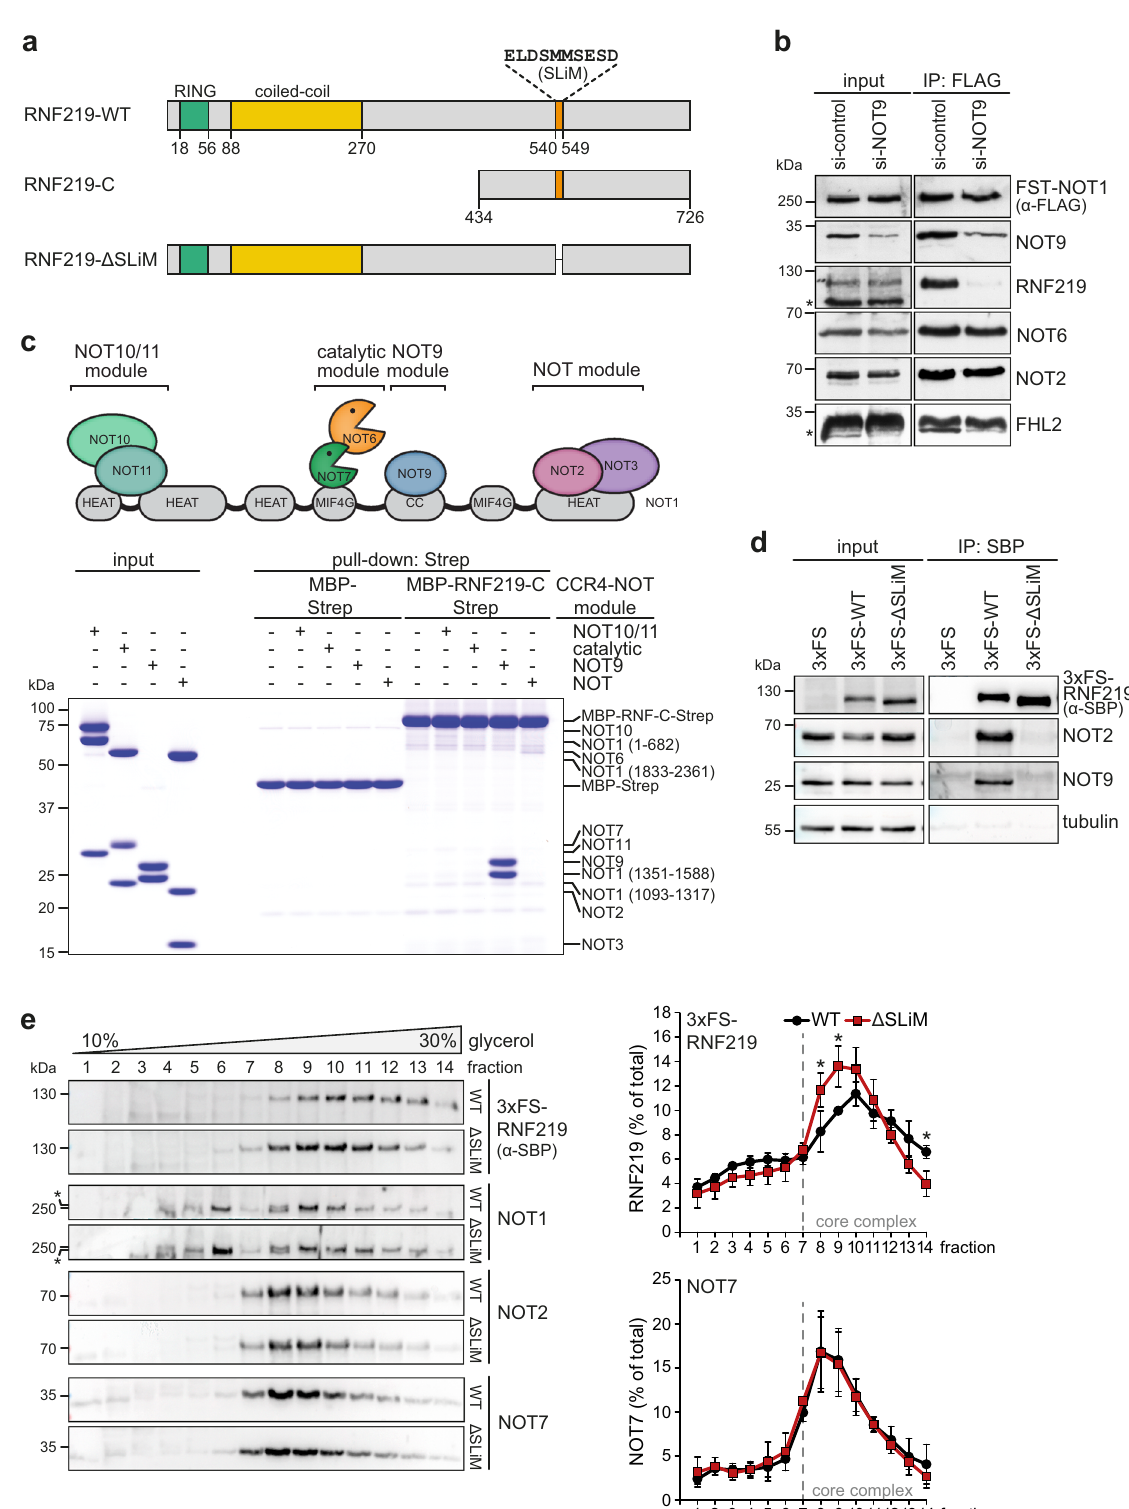
RNF219 is a CCR4-NOT-associated active ubiquitin ligase . RNF219 harbors an N-terminal RING-type E3 ligase domain, which displays high amino acid sequence conservation among vertebrates (Supplementary Fig. 6a) and conforms to the con- sensus sequence of other RING-type E3 ligases (Fig. 3a) 64 . Indeed, two recent studies independently con fi rmed that RNF219 is an active E3 ubiquitin ligase 62,63 . NATURE COMMUNICATIONS| (2021) 12:7175